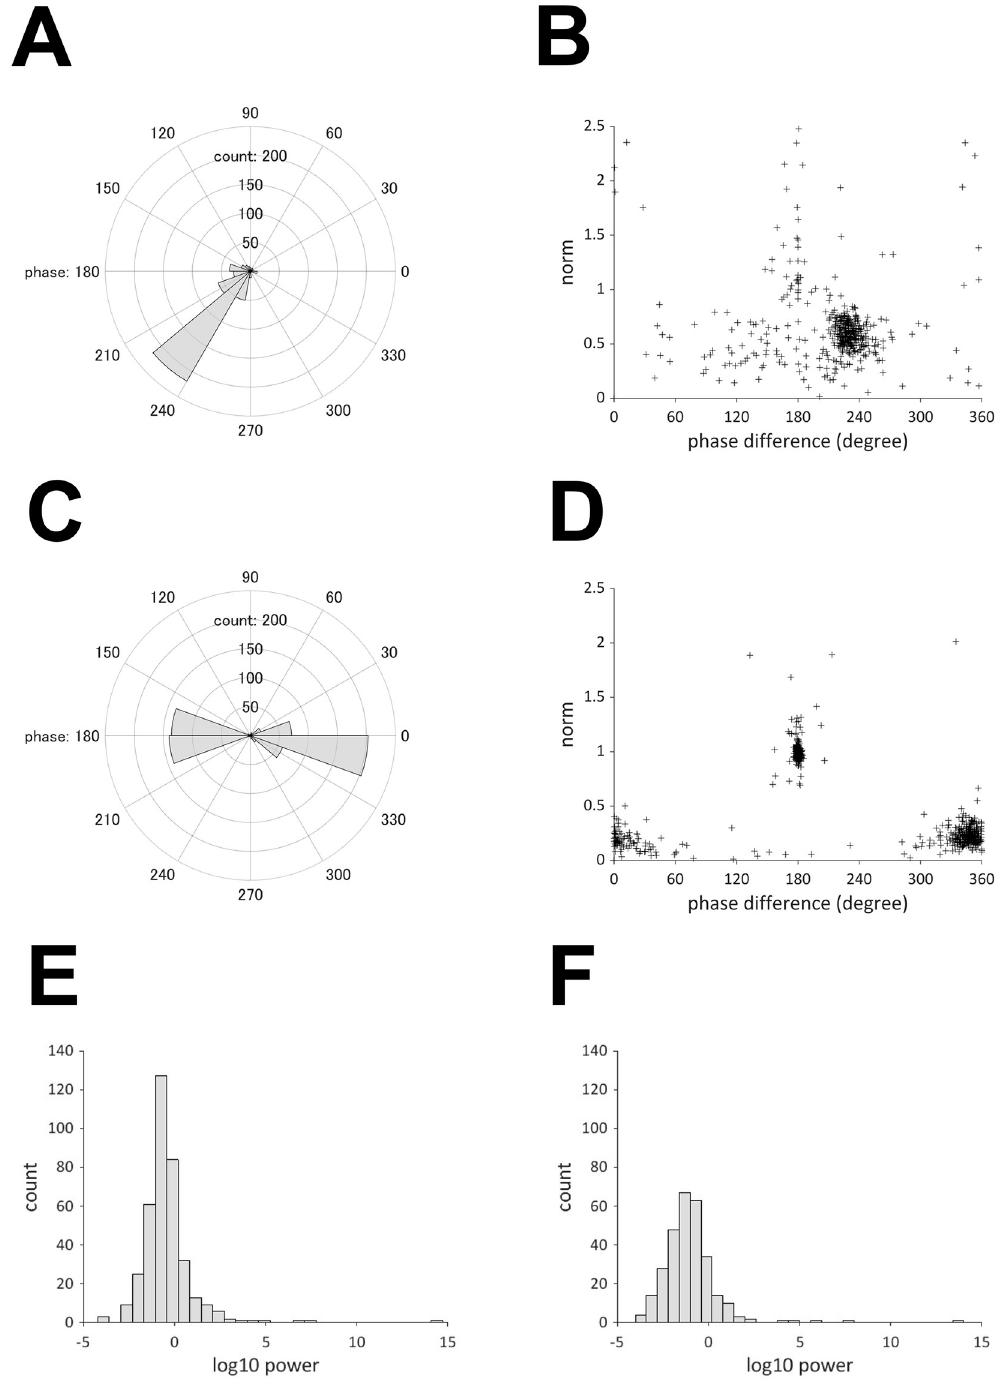
Fig 12. (A) Histogram of phase difference (0.01–0.1 Hz). (B) Scatter plot of phase difference and norm of the projection vector (0.01–0.1 Hz). (C) Histogram of phase difference (1.6–2.4 Hz). (D) Scatter plot of phase difference and norm of projection vector (1.6–2.4 Hz). (E) Histogram of power of pulse wave. (F) Histogram of the power of the mirroring